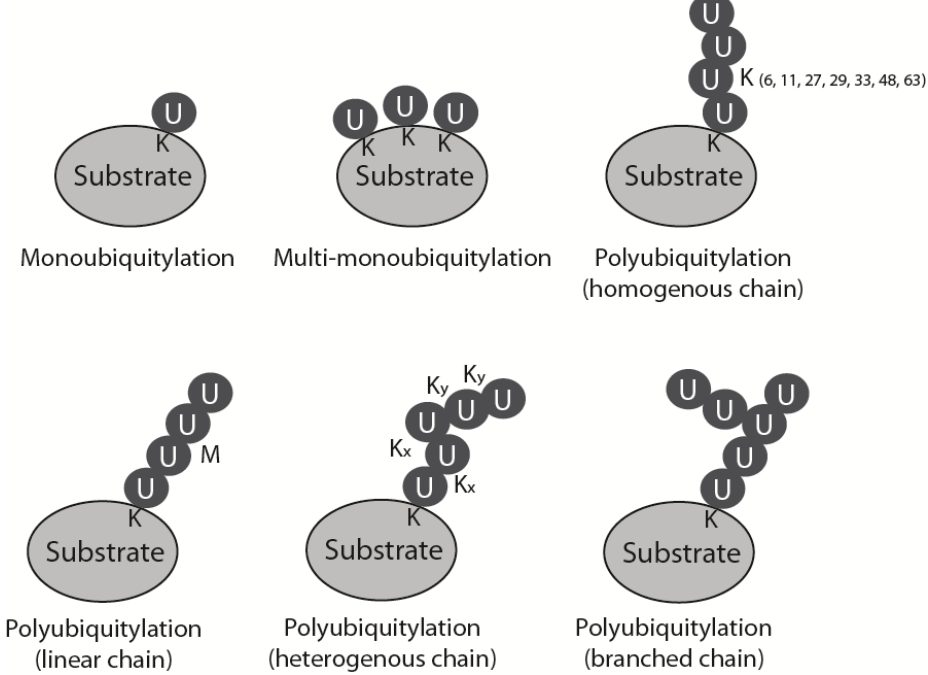
Figure 1. Types of substrate ubiquitylation. Mono-, multimono- and polyubiquitylation is presented. Different types of polyubiquitin chains: linked through specific but the same lysine throughout the chain (homogenous chains), linked through N-terminal methionine (linear chains), linked through alternative lysines (heterogenous chains) and chains with on e of the chain’s ubiquitin modified by two further ubiquitins linked through different lysines (branched